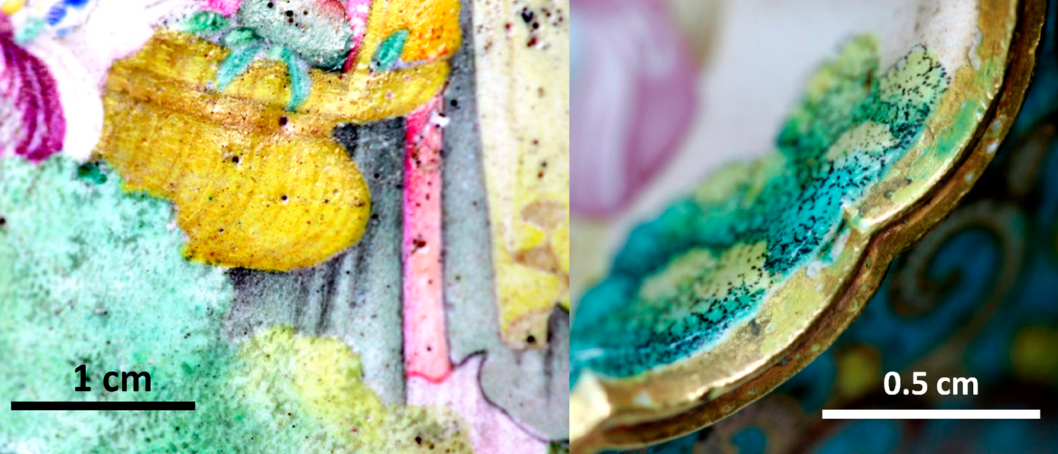
Figure 3. Detailed images of the enamels of the gold ewer décor (F1467C). Table 1. Composition of the metal parts of the objects studied (metal wt%).